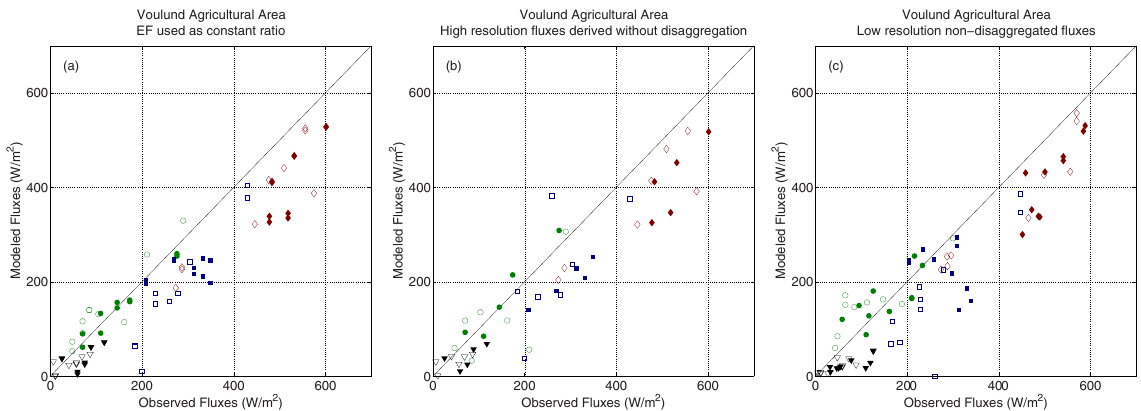
Figure 8. Comparison of modelled vs. observed fluxes at the Voulund agricultural area with meteorological inputs provided by the ERA- Interim data set. Modelled fluxes are instantaneous at the time of satellite overpass and observed fluxes are 30min averaged EC measurements. The three panels show: (a) fluxes disaggregated using the evaporative fraction method, (b) high-resolution fluxes derived with TSEB model without disaggregation, (c) low-resolution, non-disaggregated fluxes modelled with DTD. The fluxes modelled at 30m resolution ( a and b ) are aggregated to EC footprint. Rectangles represent LE, circles represent H , triangles represent G and diamonds represent R n . Empty symbols indicate aggregated fluxes where pixels comprising 70% of EC footprint were present (S70 set), and full symbols where in addition there were no missing Landsat pixels within the MODIS pixels (S100 set).